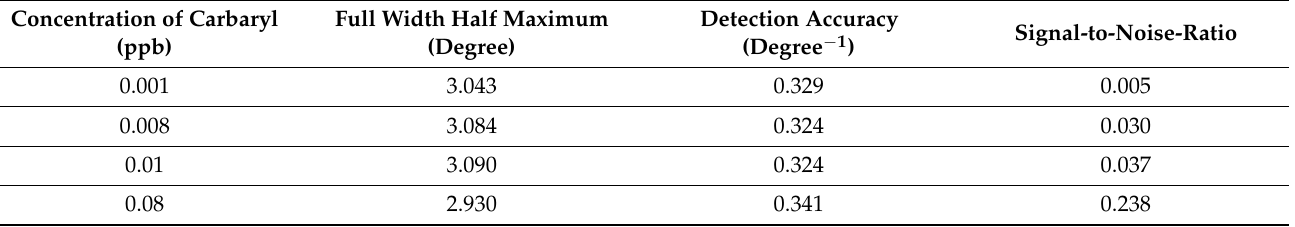
Table 3. The FWHM, DA, and SNR values for GQDs − PVA thin film in the detection of carbaryl (0.001–0.08 ppb).